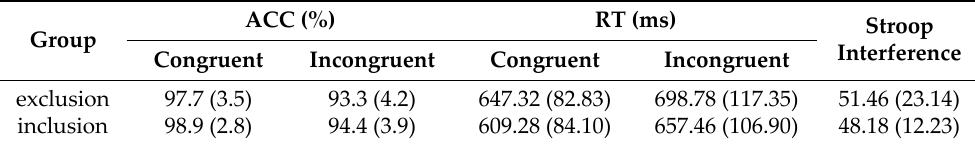
Table 3. Mean (and standard deviations) of the RTs (ms) and ACCs (%) for the hot Stroop task. ACC (%) RT (ms) Stroop Group InterferenceCongruent